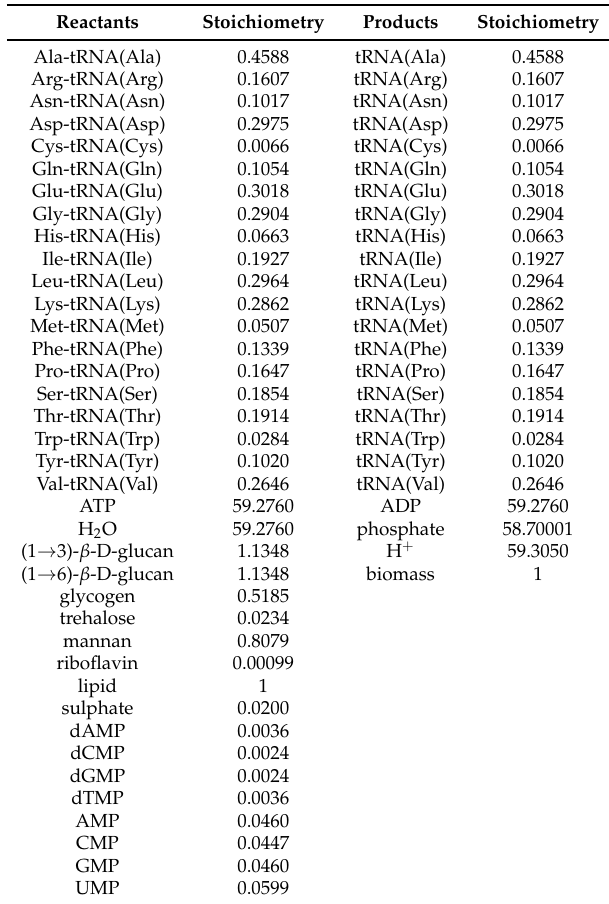
Table A3. Biomass reaction of the Yeast 6.06 model.